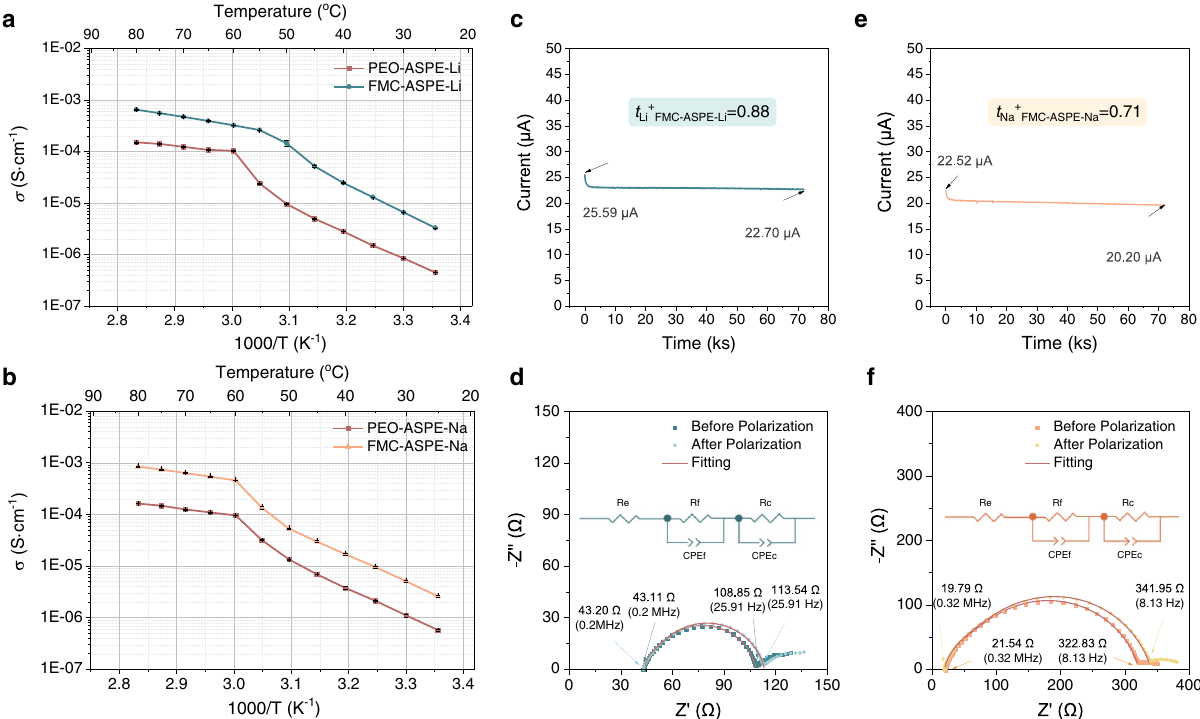
Fig. 3 Ion conduction properties of the FMC-ASPE-Li/Na and PEO-ASPE-Li /Na membranes. a , b Ionic conductivity-temperature functions of a FMC- ASPE-Li vs. PEO-ASPE-Li and b FMC-ASPE-Na vs. PEO-ASPE-Na. c – f Cation transference number test results of FMC-ASPE-Li and FMC-ASPE-Na. Polarization (POL) result ( c ) and fi tted electrochemical impedance spectra (EIS) before and after the POL ( d ) of FMC-ASPE-Li, POL result ( e ), and fi tted EIS before and after POL ( f ) of